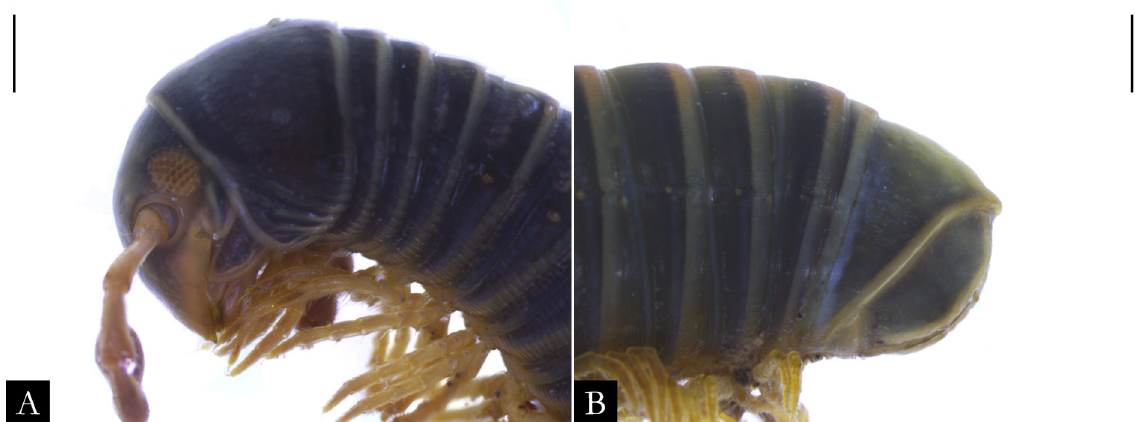
Fig. 89. Pseudonannolene maritima Schubart, 1949, ♀ (IBSP 658), in lateral view. A . Anterior region. B . Posterior region. Scale bars = 1